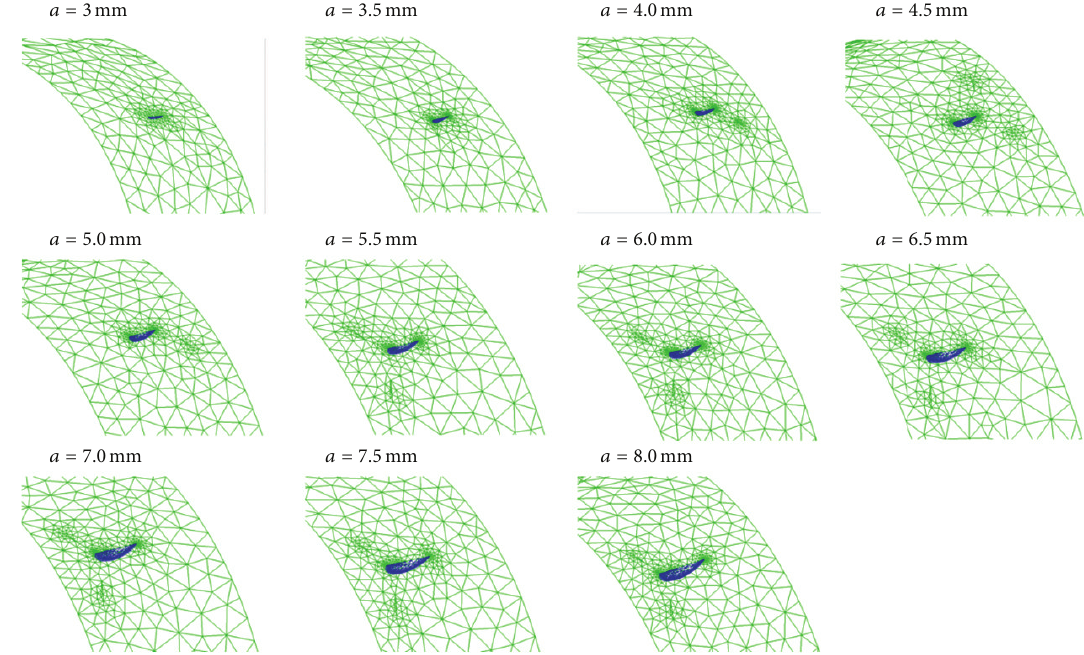
Figure 11: Growing shape and size of a longitudinal crack.